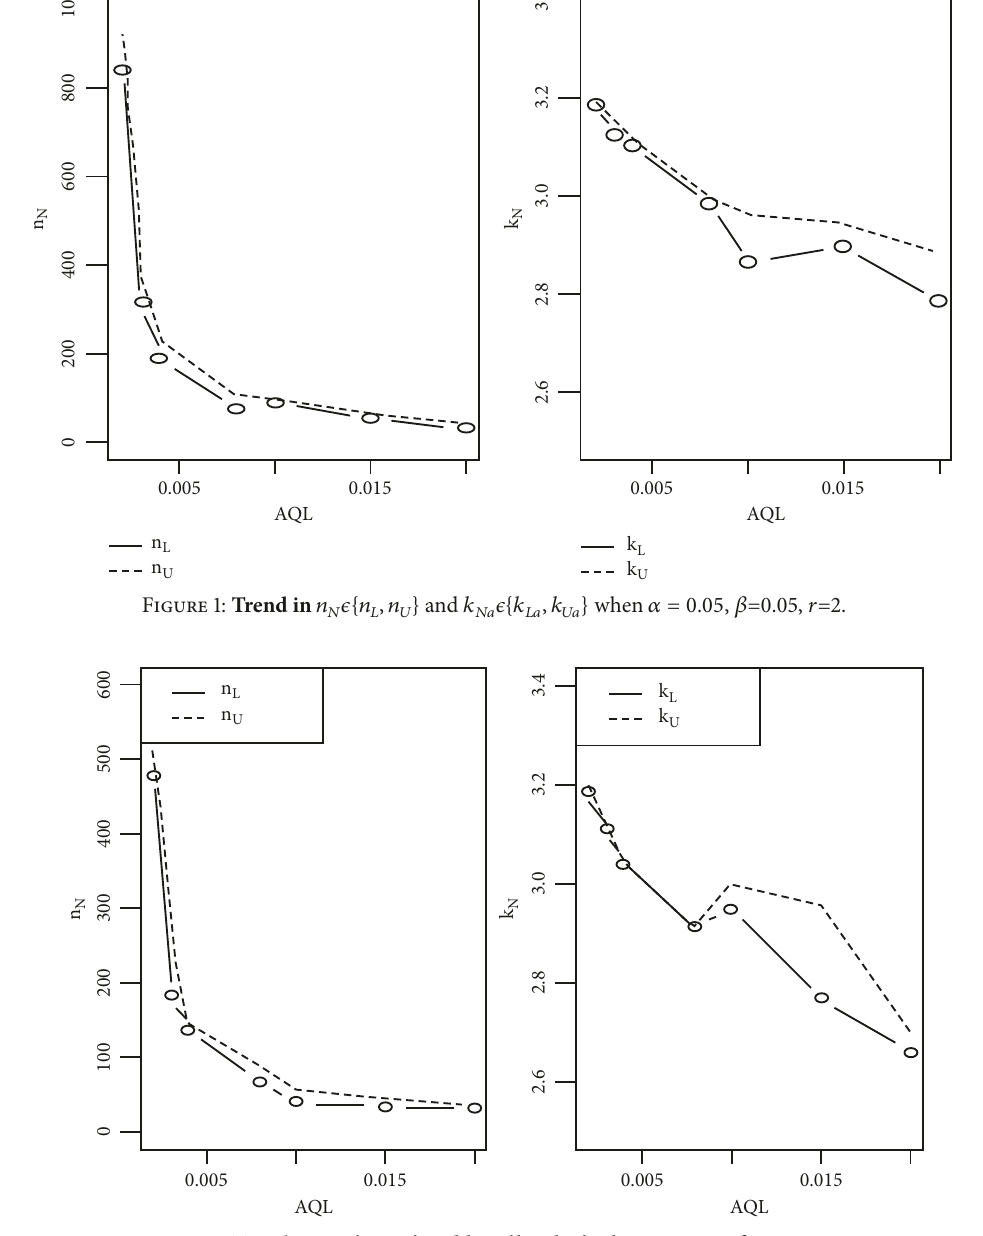
Figure 2: Trend in 𝑛 𝑁 𝜖{𝑛 𝐿 ,𝑛 𝑈 } and 𝑘 𝑁𝑎 𝜖{𝑘 𝐿𝑎 , 𝑘 𝑈𝑎 } when 𝛼 = 0.05 , 𝛽 =0.05, 𝑟